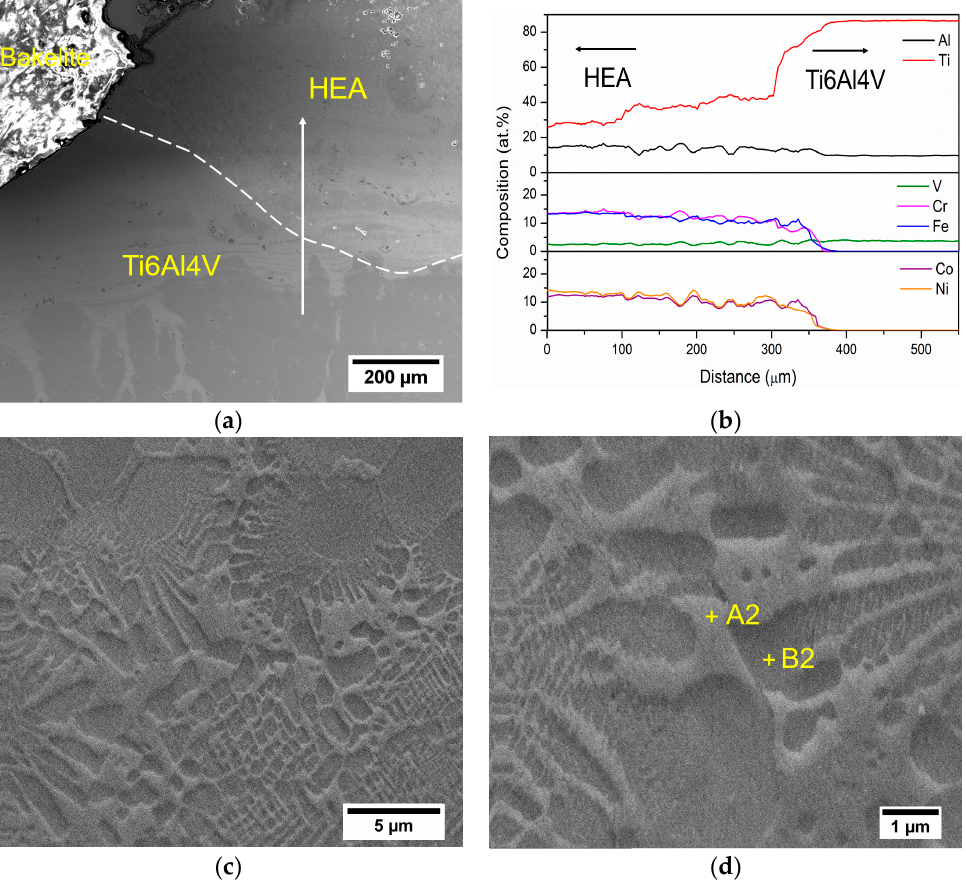
Figure 3. ( a ) Secondary electron images of the interface between the AlCoCrFeNiTi 0.5 HEA coating and Ti6Al4V substrate, ( b ) energy dispersive spectroscopy (EDS) line scan along the white arrow line in ( a ), ( c ) and ( d ) backscattered electron images of the HEA microstructure at different magnifications.